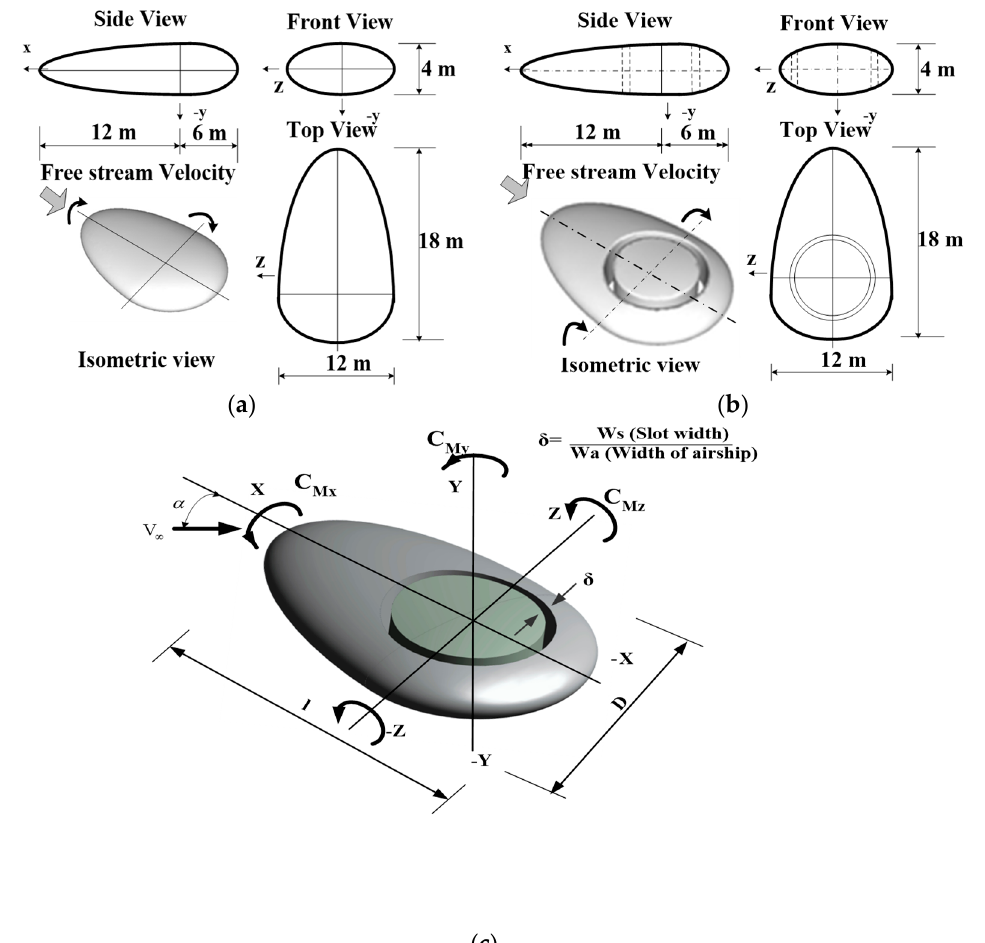
Figure 1. ( a ) Hybrid airship shape isometric view and detailed specification; ( b ) hybrid airship with circular slot opening isometric view and detailed specification; ( c ) axis system. isometric view and detailed specification; ( c ) axis